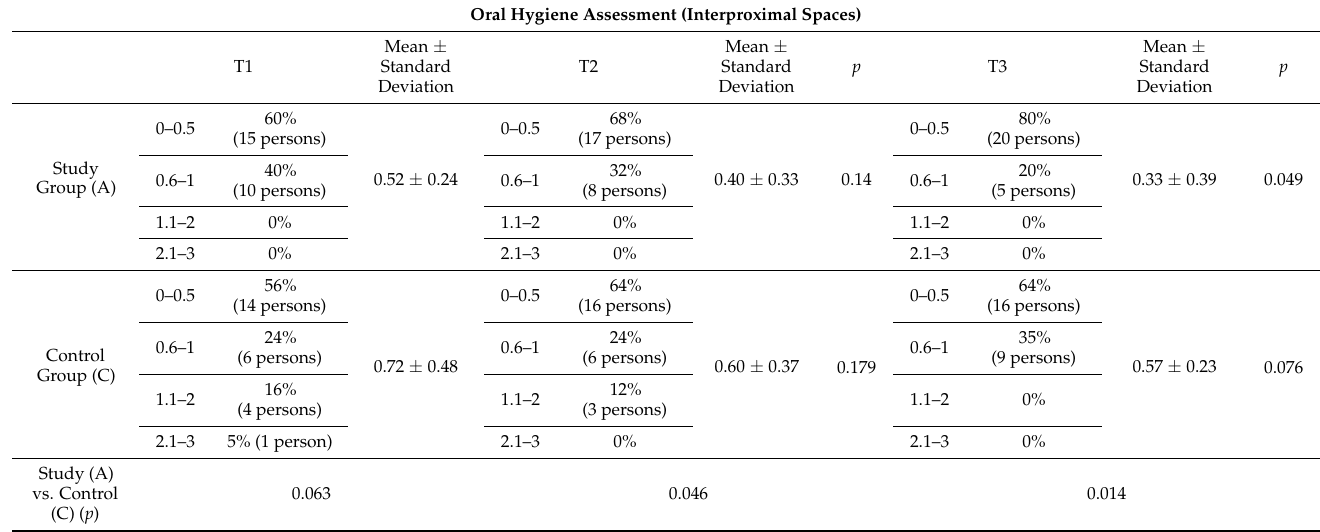
Table 2. Simplified oral hygiene index (OHI) ranges—assessment for study and control groups.